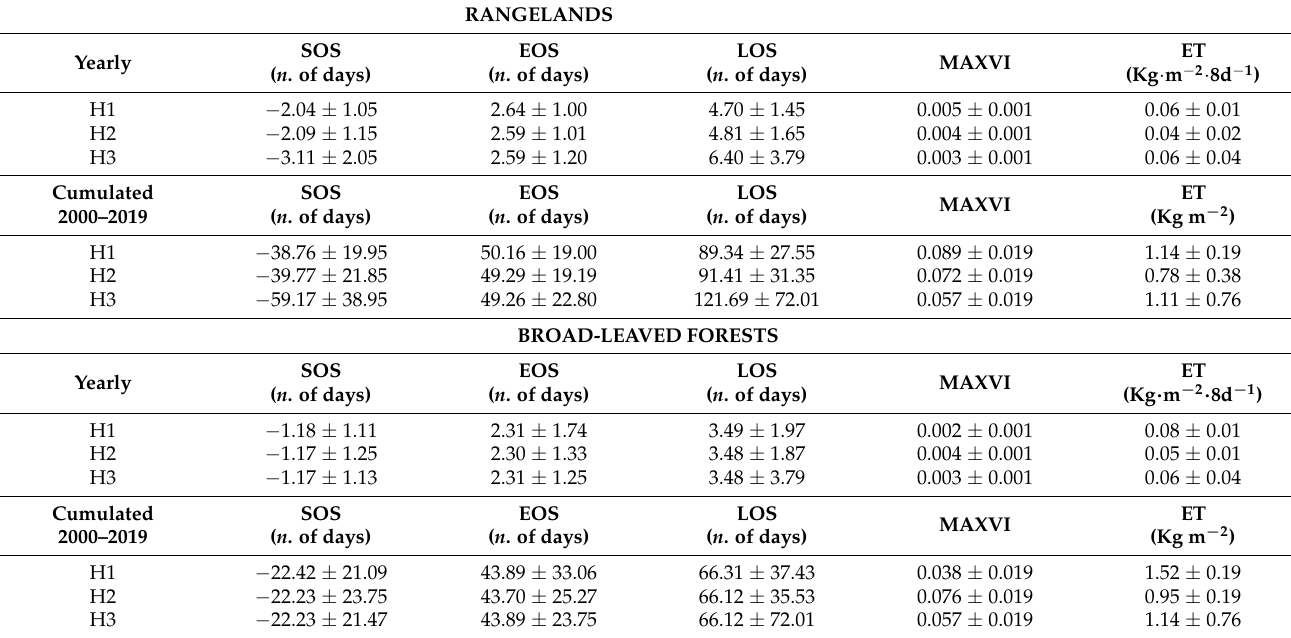
Table 5. Yearly average and cumulated (2000–2019) variations of PMs and ET along the years as estimated by 1st order polynomial regression (Figure 4). Positive values indicate a delay or lengthening of season, negative values an advance of season according to the observed trends reported in Figure 4. The first part of the table indicates the yearly gain, while the second part (cumulated) represent the overall changes in the observed period analyzed for each PMs from the starting in the year 2000 up to the end (2019). Standard deviations have been calculated to define the uncertainty margin on the basis of the estimated gain (indicated after the ±